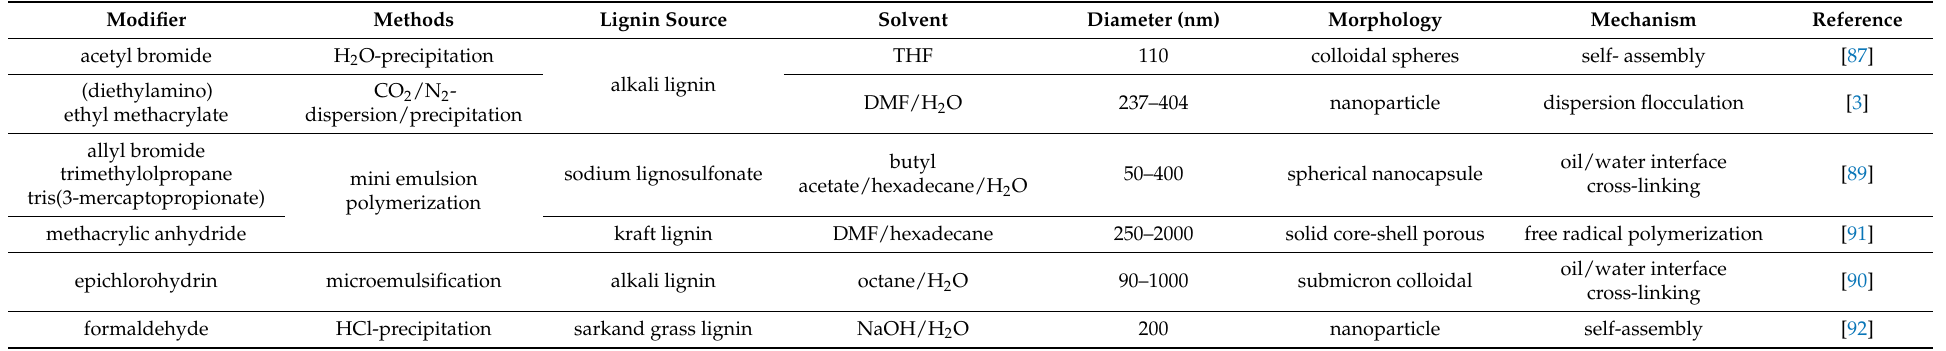
Table 6. Synthesis of Modified Lignin